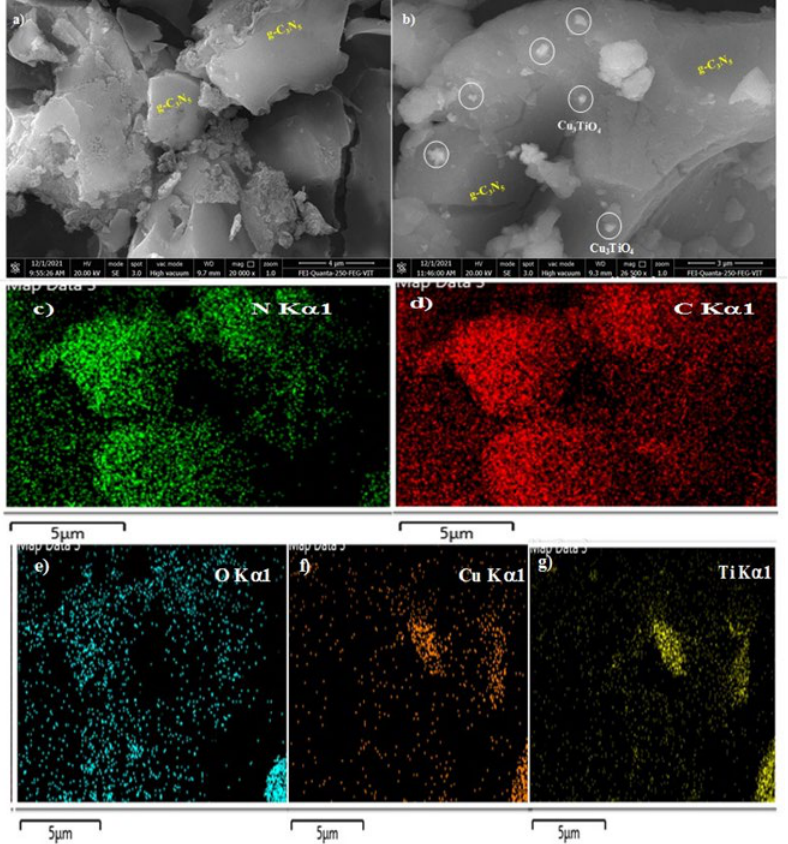
Figure 3. FE-SEM images of ( a ) g-C 3 N 5 ( b ) 10% CN5CT nanocomposite and ( c – g ) elemental mapping of 10% CN5CT.